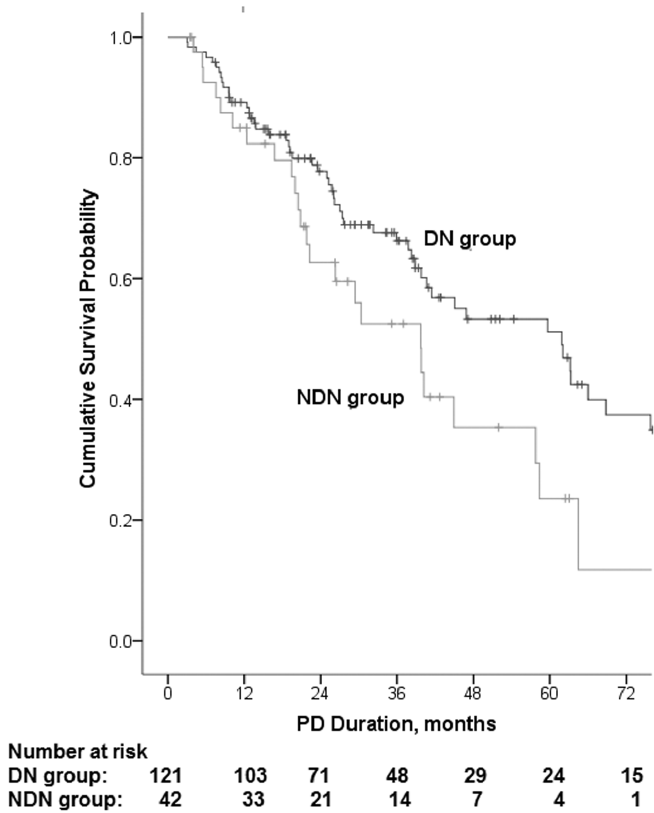
Fig 1. Kaplan — Meier survival analysis for patient survival. Kaplan — Meier analysis showed that patient survival in NDN group was significantly inferior to DN group (log rank 4.830, P = 0.028).